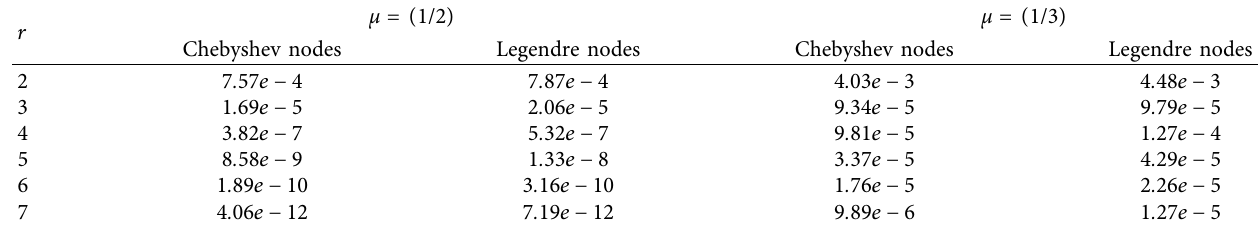
Figure 1: Plot of the L 2 -errors taking μ � ( 1/2 ) (a) and μ � ( 1/3 ) (b) at the Legendre and Chebyshev nodes for Example 1. Table 2: The L 2 -errors at the Legendre and Chebyshev nodes taking different μ for Example